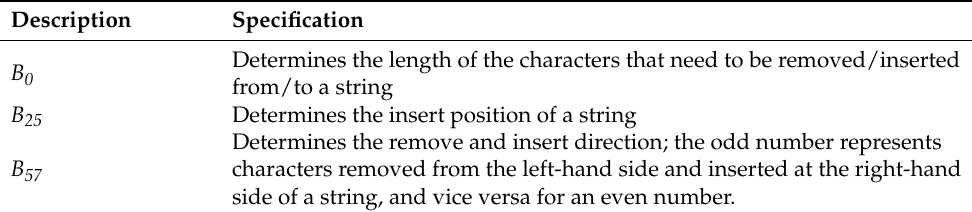
Figure 1. Proposed lightweight permutation operation. Table 2. Permutation operation description.